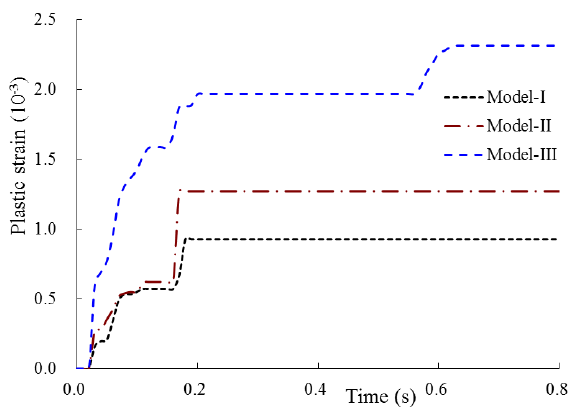
Figure 7. Max plastic strain time-history of concrete.